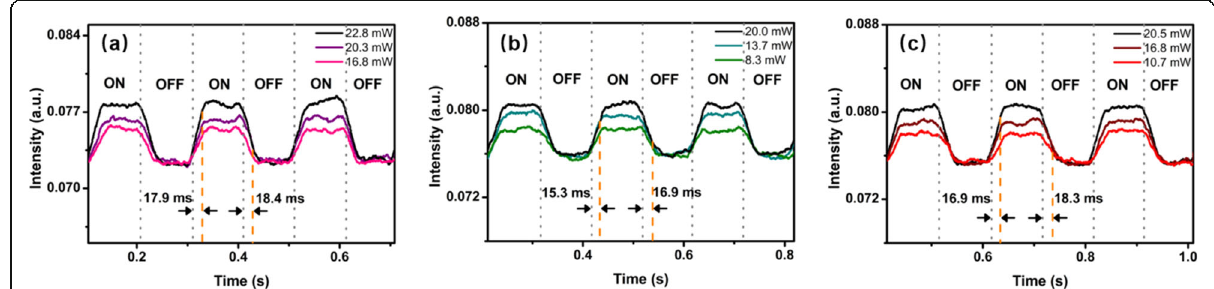
Fig. 13 Response time of the MF coated with WSe 2 nanosheets with a pump light wavelength of a violet laser illumination, b green laser illumination, and c red laser illumination